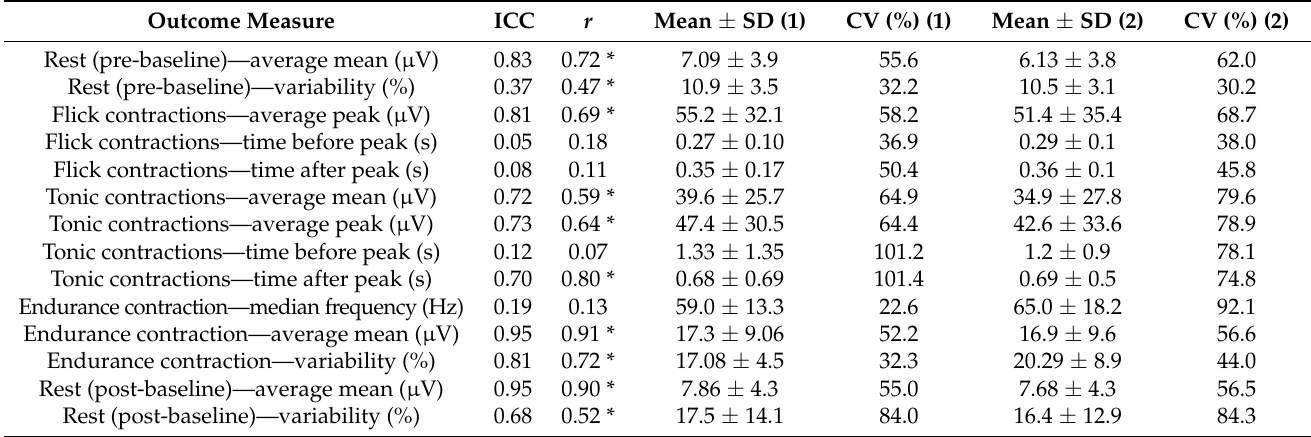
Table 1. The Glazer surface electromyography (sEMG) protocol between-trial